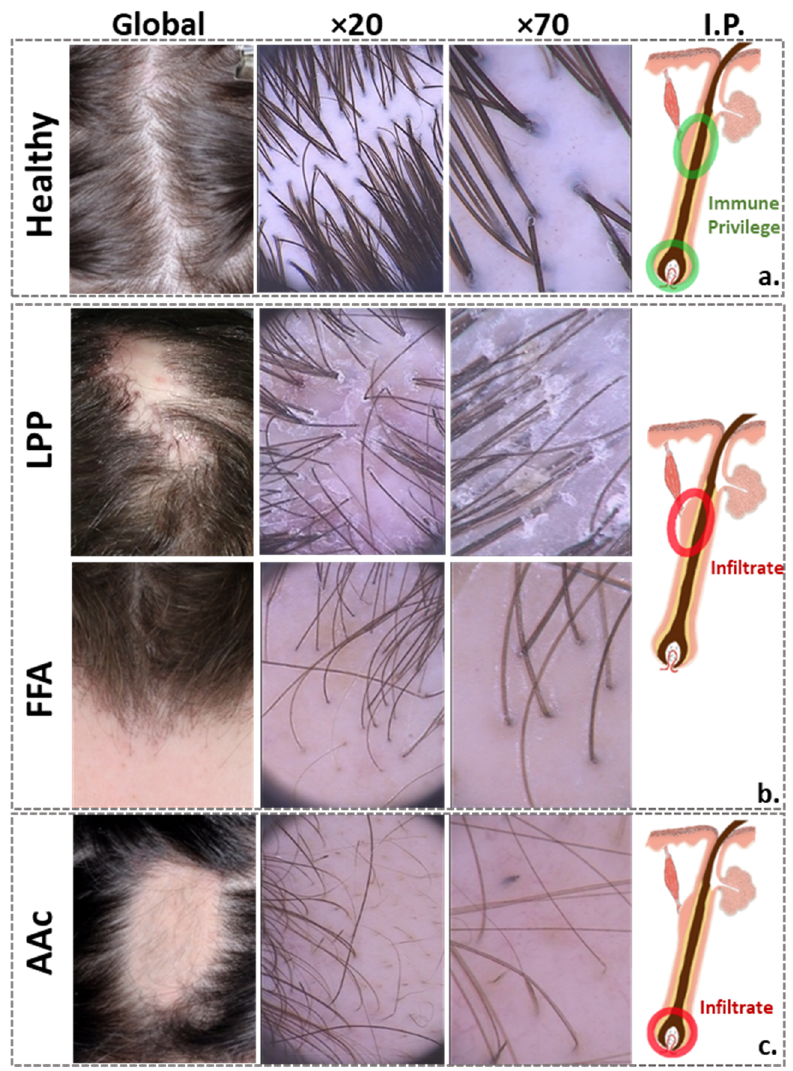
Figure 1. Clinical and dermoscopic pictures of healthy scalp and inflammatory scalp diseases. From left to right: representative global hair photography (VISIA-CR ® , Canfield Scientific Inc., Fairfield, NJ, USA), dermoscopic scalp examinations at 20-fold and 70-fold magnification (Fotofinder ® TeachScreen Systems software GmbH; Bad Birnbach, Germany), and schematic of a HF, showing the ( a ) immune privilege areas of the healthy HF; the ( b ) inflammation sites of scarring alopecia, located around the stem cell-bearing bulge area, considered to be the “critical zone” for HF homeostasis and disease pathogenesis, because its integrity is required for stem cell survival and HF regrowth; and ( c ) non-scarring alopecia, where inflammation mainly affects the peribulbar region, allowing a possible HF regrowth. Clinically, LPP typically presents as patchy hair loss, with scaling and redness at the edges, whereas FFA typically presents with band-like, receding frontal hair line and eyebrow loss. Despite the completely different clinical characteristics of FFA and LPP, their histopathological findings